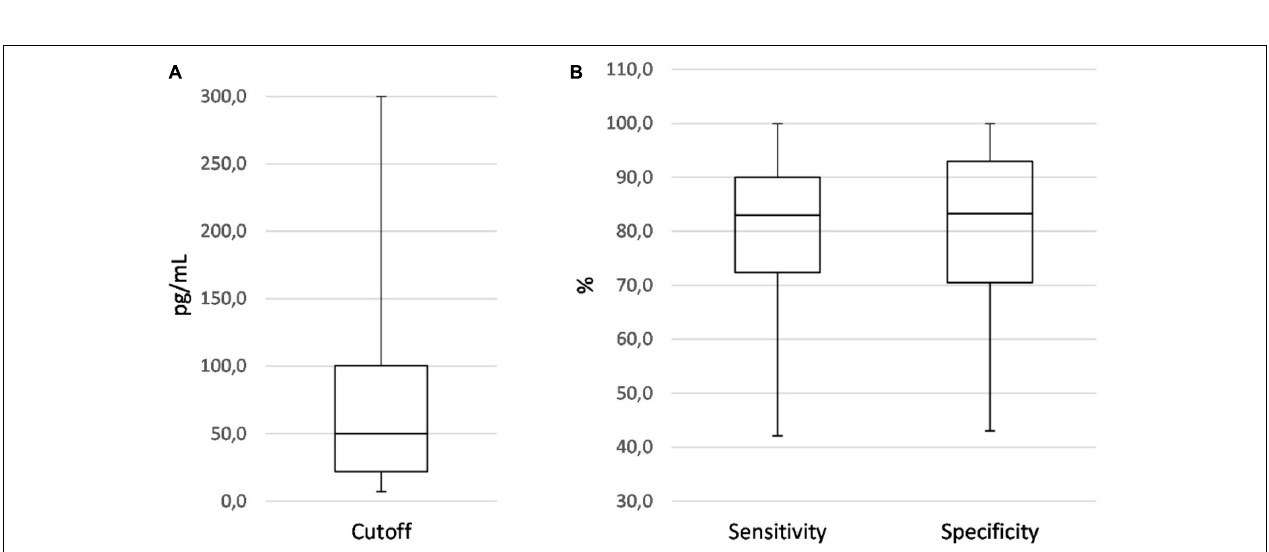
FIGURE 2 | Boxplots showing the distribution of IL-6 cutoff (A) , sensitivity, and specificity values (B) of all diagnostic accuracy studies on EONS using neonatal samples.